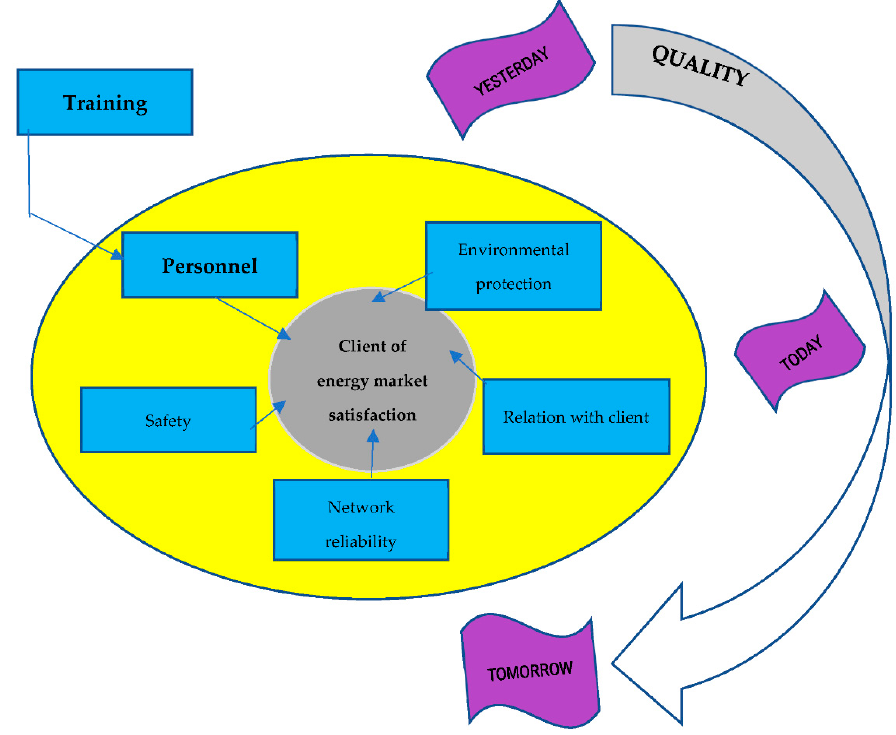
Figure 9. Model of elements determining quality and value for customers in the energy market.